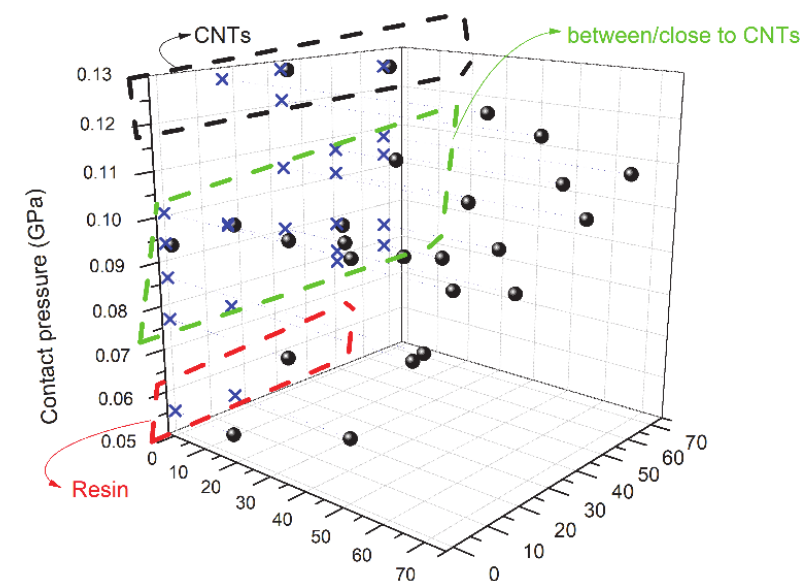
Figure 13: Contact pressure (as resistance to applied load) mapping, at 300nm of displacement for a grid of 70 μ m 2 for polypropylene with 2 %